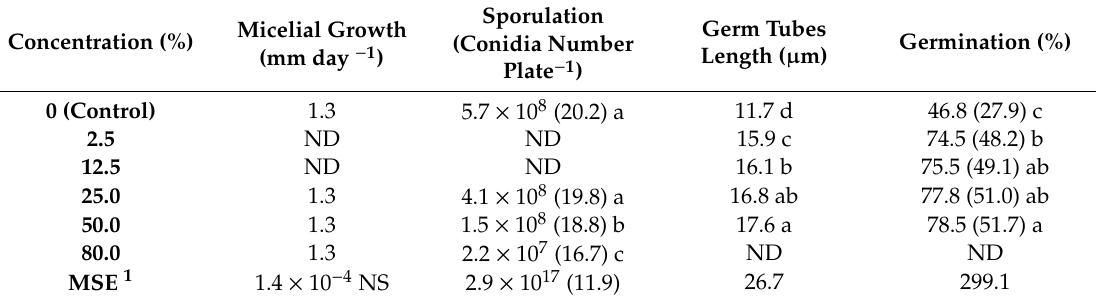
Table 5. E ff ect of di ff erent concentrations of Penicillium rubens strain 212 (PO212) crude extract (CE7) on growth of strain 1A of Fusarium oxysporum f.sp. lycopersici (FOL1A). Micelial Growth Concentration (%)